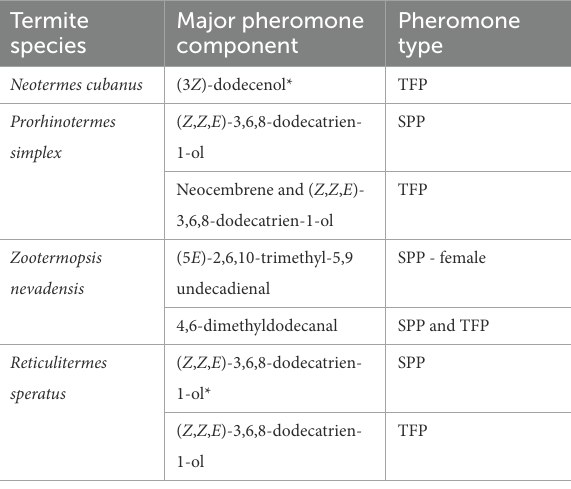
TABLE 1 List of trail-following pheromones (TFPs) and sex-pairing pheromones (SPPs) reported from selected termite species studied here at the level of chemosensory genes.